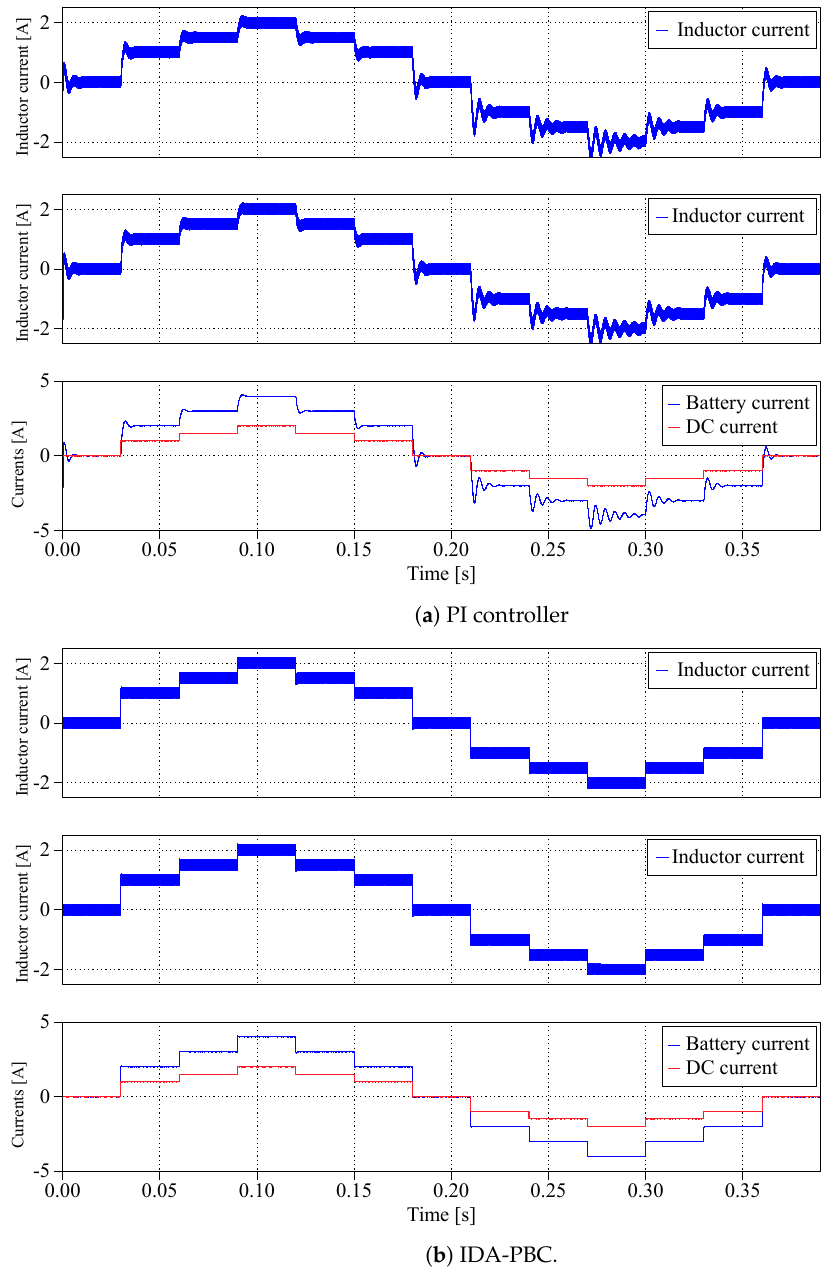
( b ) IDA-PBC. Figure 5. The dynamic response of currents associated with the interleaved boost converter under different DC current